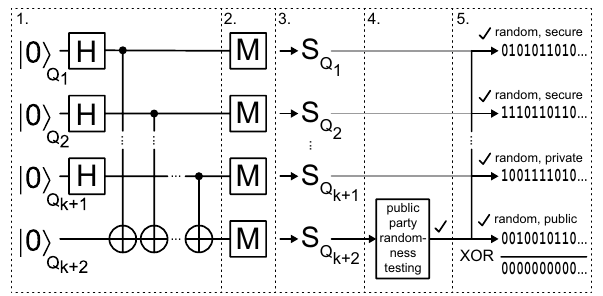
Figure 7. Protocol of the multiqubit, entanglement based, cryptographically secure QRNG with public randomness verification 60